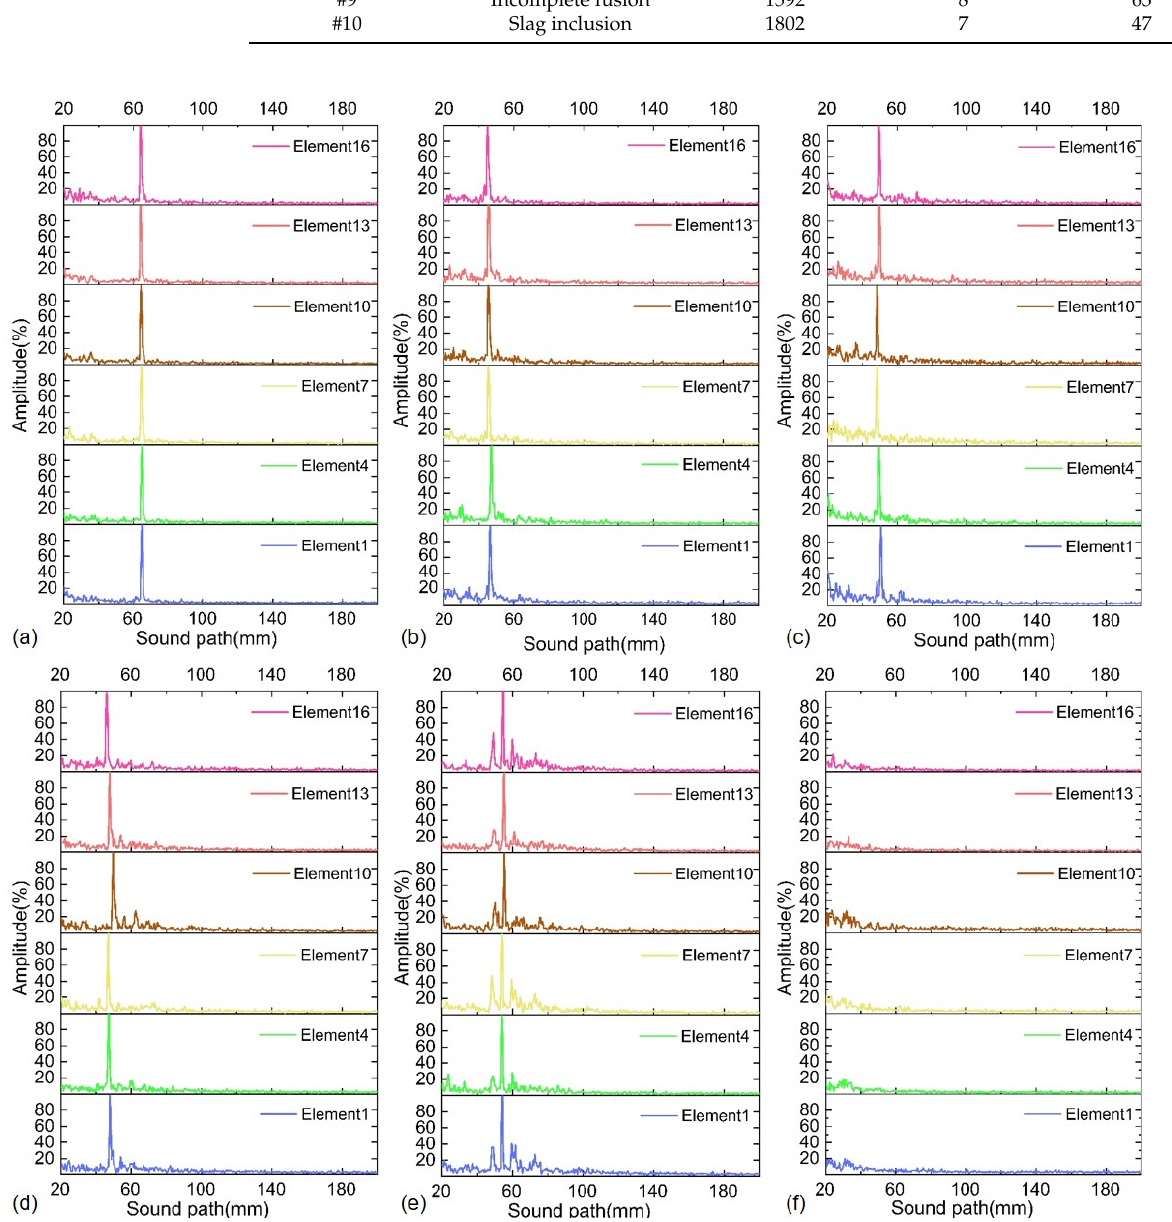
Figure 11. Detected location distributions for five different girth weld defects and defect-free case: ( a ) gas pores, ( b ) incomplete penetration, ( c ) cracks, ( d ) incomplete fusion, ( e ) slag inclusion, ( f ) no defect.